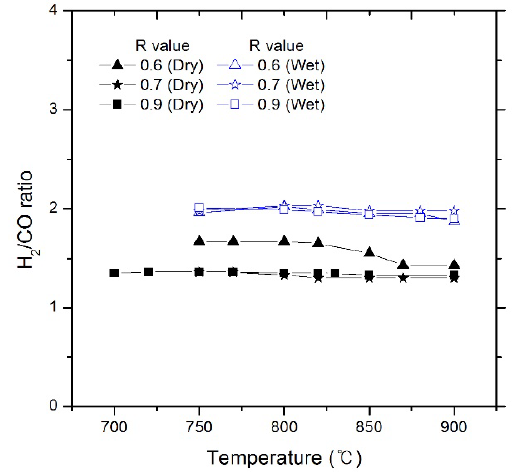
Figure 13. E ff ect of temperature and R value on H 2 / CO ratio. Figure 13. Effect of temperature and R value on H Figure 13. Effect of temperature and R value on H 2 /CO ratio.